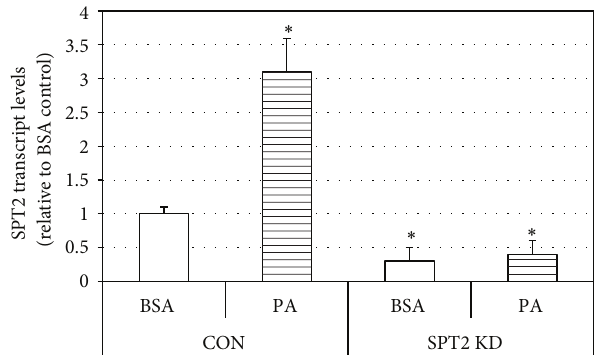
Figure 3: To confirm efficacy of SPT2 knockdown in murine myotubes, cells were treated with palmitic acid (PA, 0.5 mM). ∗ 𝑃 < 0.05 , PA versus